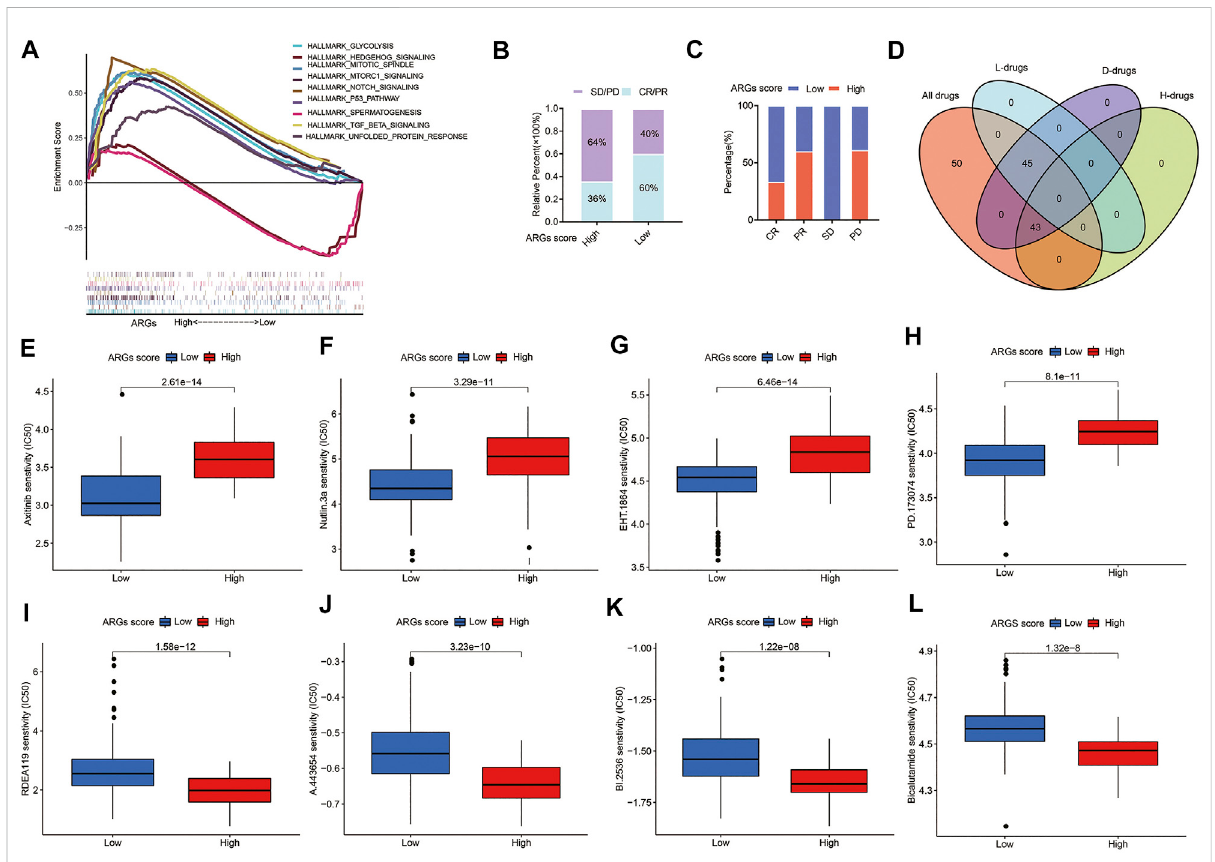
FIGURE 8 Relationships between ARGs score and therapeutic sensitivity: (A) GSEA analyzed the biological pathways of two ARGs score groups in the PC cohort; (B) Theratio ofworseoutcomesaftersurgery isgreatly elevated inthehighARGs scoregroup; (C) The proportion ofclinicaloutcomesinPC patients with high and low ARGs score after surgery; (D) Venn diagram for summarizing included compounds from GDSC datasets; (E – H) The top 4 chemotherapeutic drugs PC patients with low ARGs score group are more susceptible to; (I – L) The top 4 chemotherapeutic drugs PC patients with high ARGs score group are more susceptible to. H, High ARGs score; L, Low ARGs score; D,